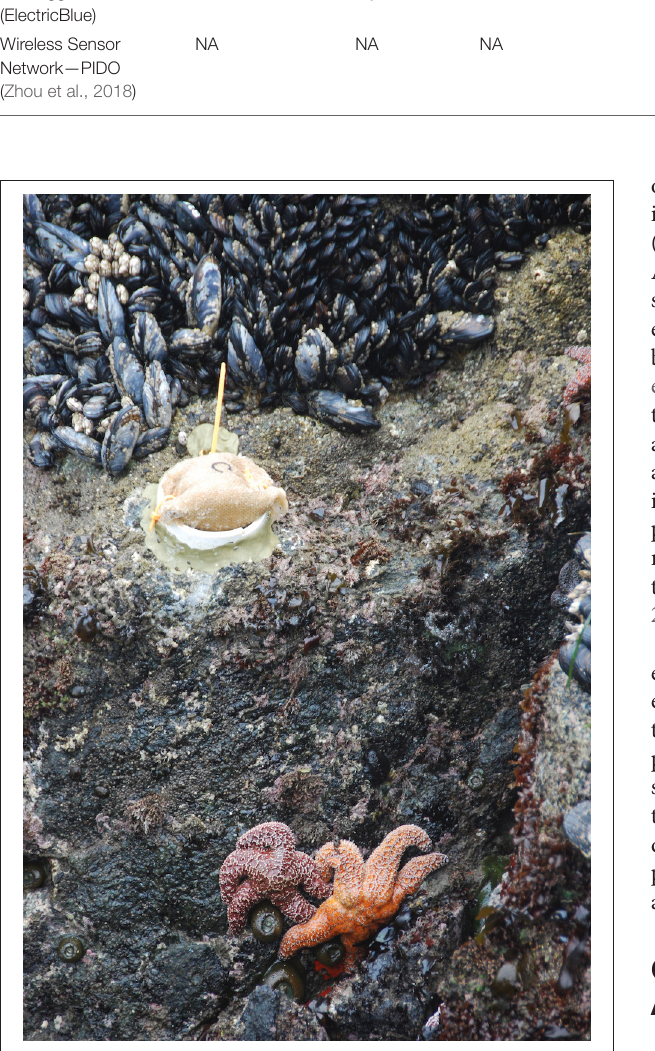
FIGURE 4 | A “roboseastar” biomimic deployed in the intertidal next to live seastars ( Pisaster ochraceus ) and their mussel prey. An iButton temperature logger is embedded within the foam and the unit is affixed to the rock using marine epoxy.